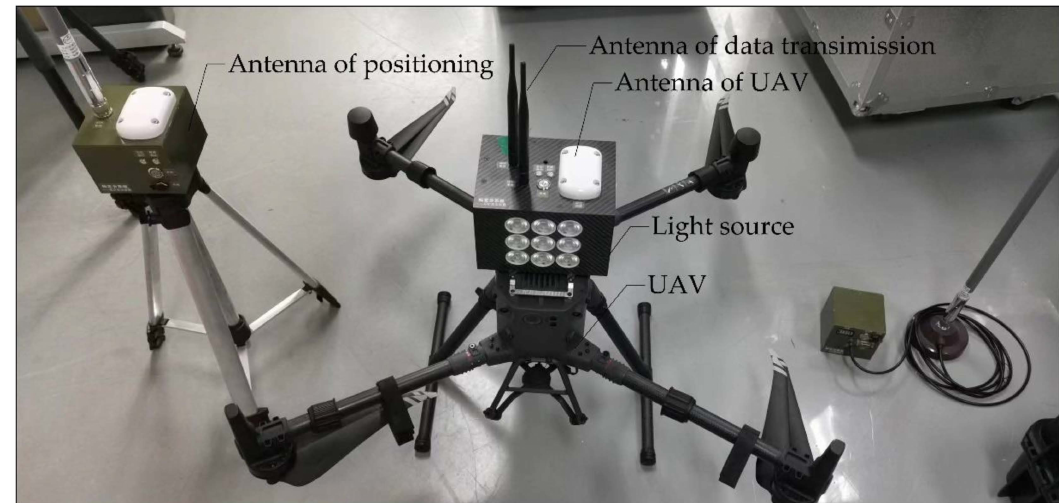
Figure 11. Prototype of the UAV featuring the mounted light source, used as the 3D point.